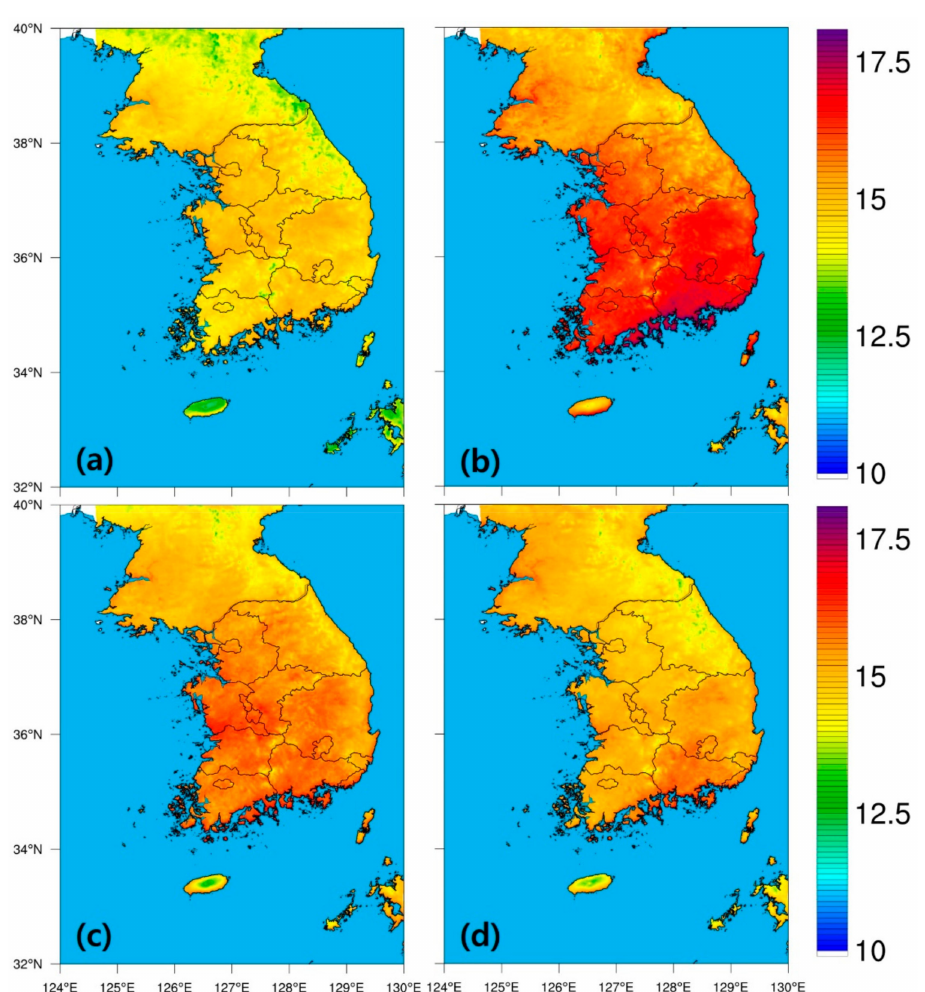
Figure 13. Horizontal distribution of annual capacity factor that is estimated by the UASIBS–KIER model in 2016 ( a ), 2017 ( b ), 2018 ( c ), and 2019 ( d